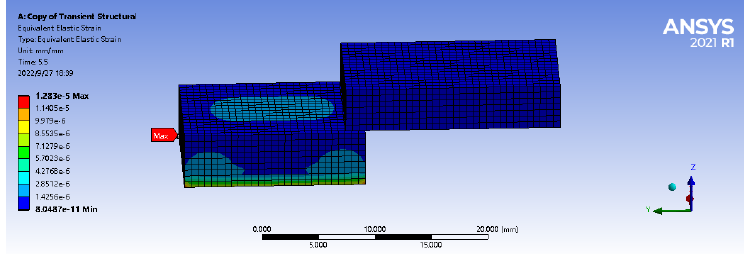
Figure 11. Simulation model of sliding matrix.